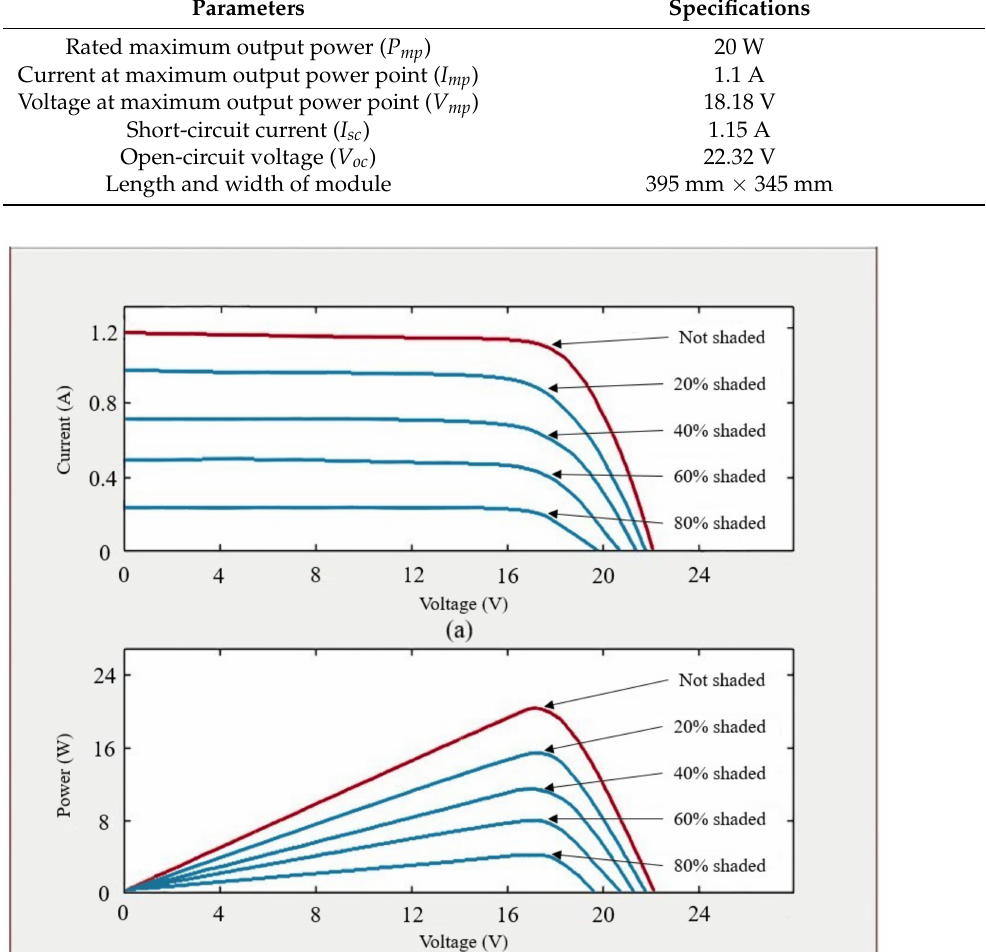
Table 1. Data specifications of electrical parameters of photovoltaic modules produced by Sunworld [21]. Parameters